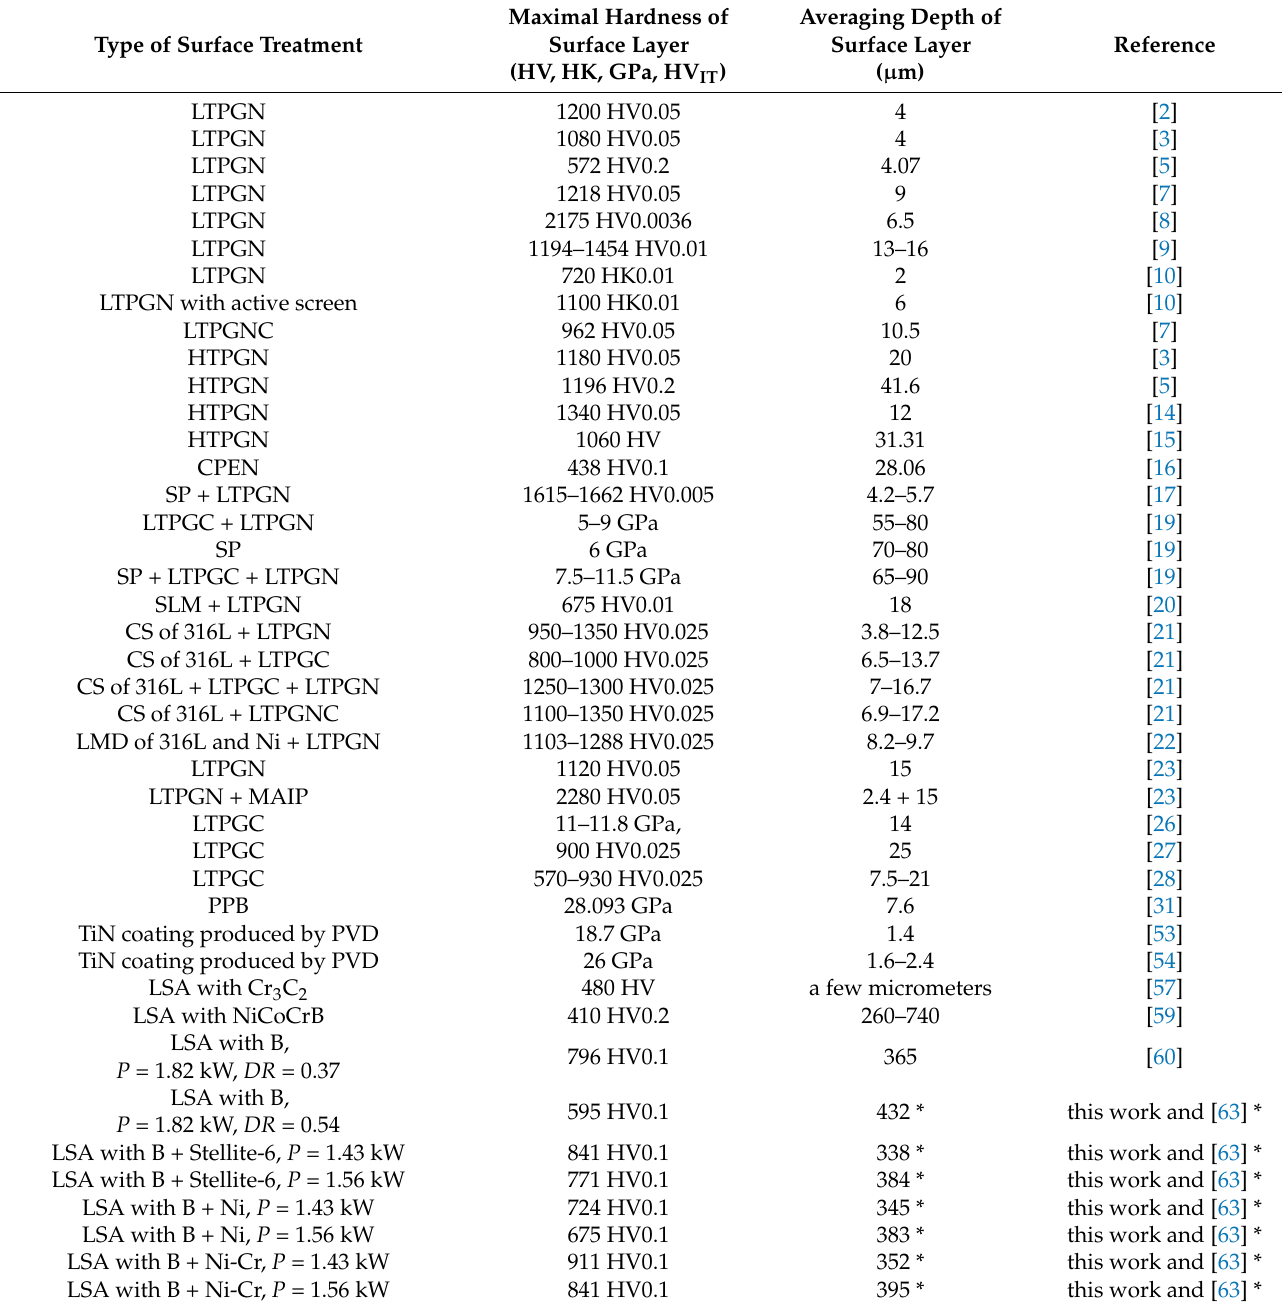
Table 1. Maximal hardness values and averaging depths of the surface layers measured after the surface treatment of austenitic steel using various physical